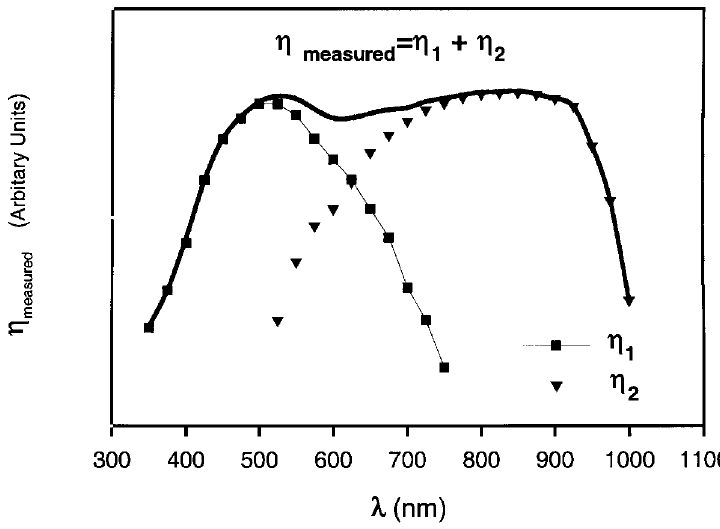
FIGURE 4 Qualitative spectral response of the Al = a-SiC:H Schottky diode included in the structure Al = a-SiC:H = c-S(n) = Al. The solid line represents the measured quantum efficiency Z